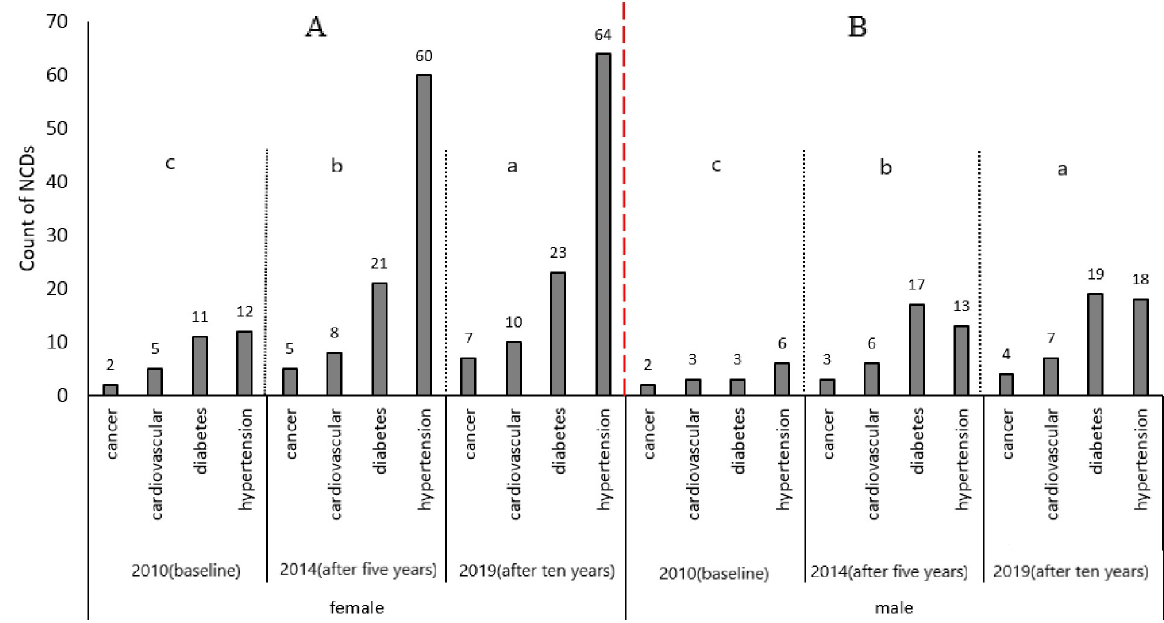
Fig 5. Analysis of NCD prevalence by gender, with ‘mean NCDs count separation letter’. A–Female category; B–Male category; a–Time interval after ten years; b–Time interval after five years; c–Time at baseline of the study (2010).